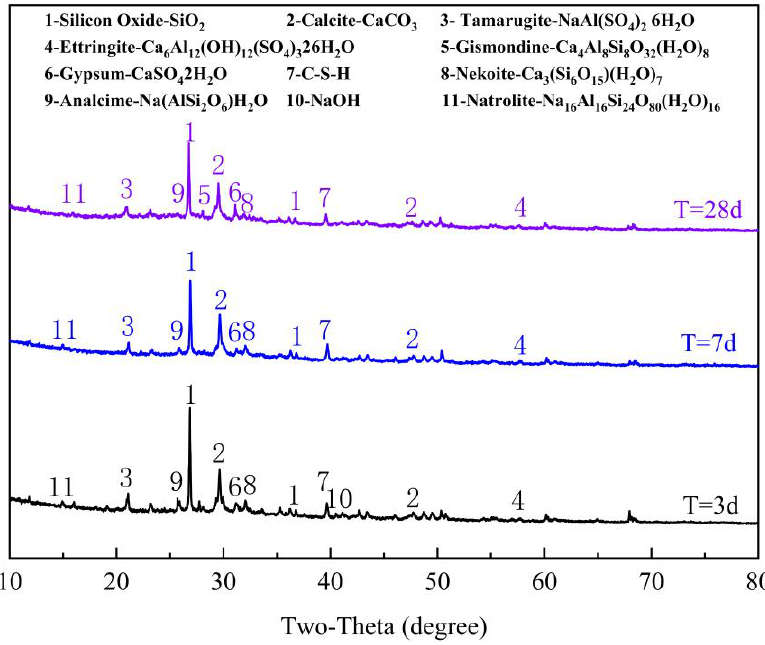
Water 2023 , 15 , 91